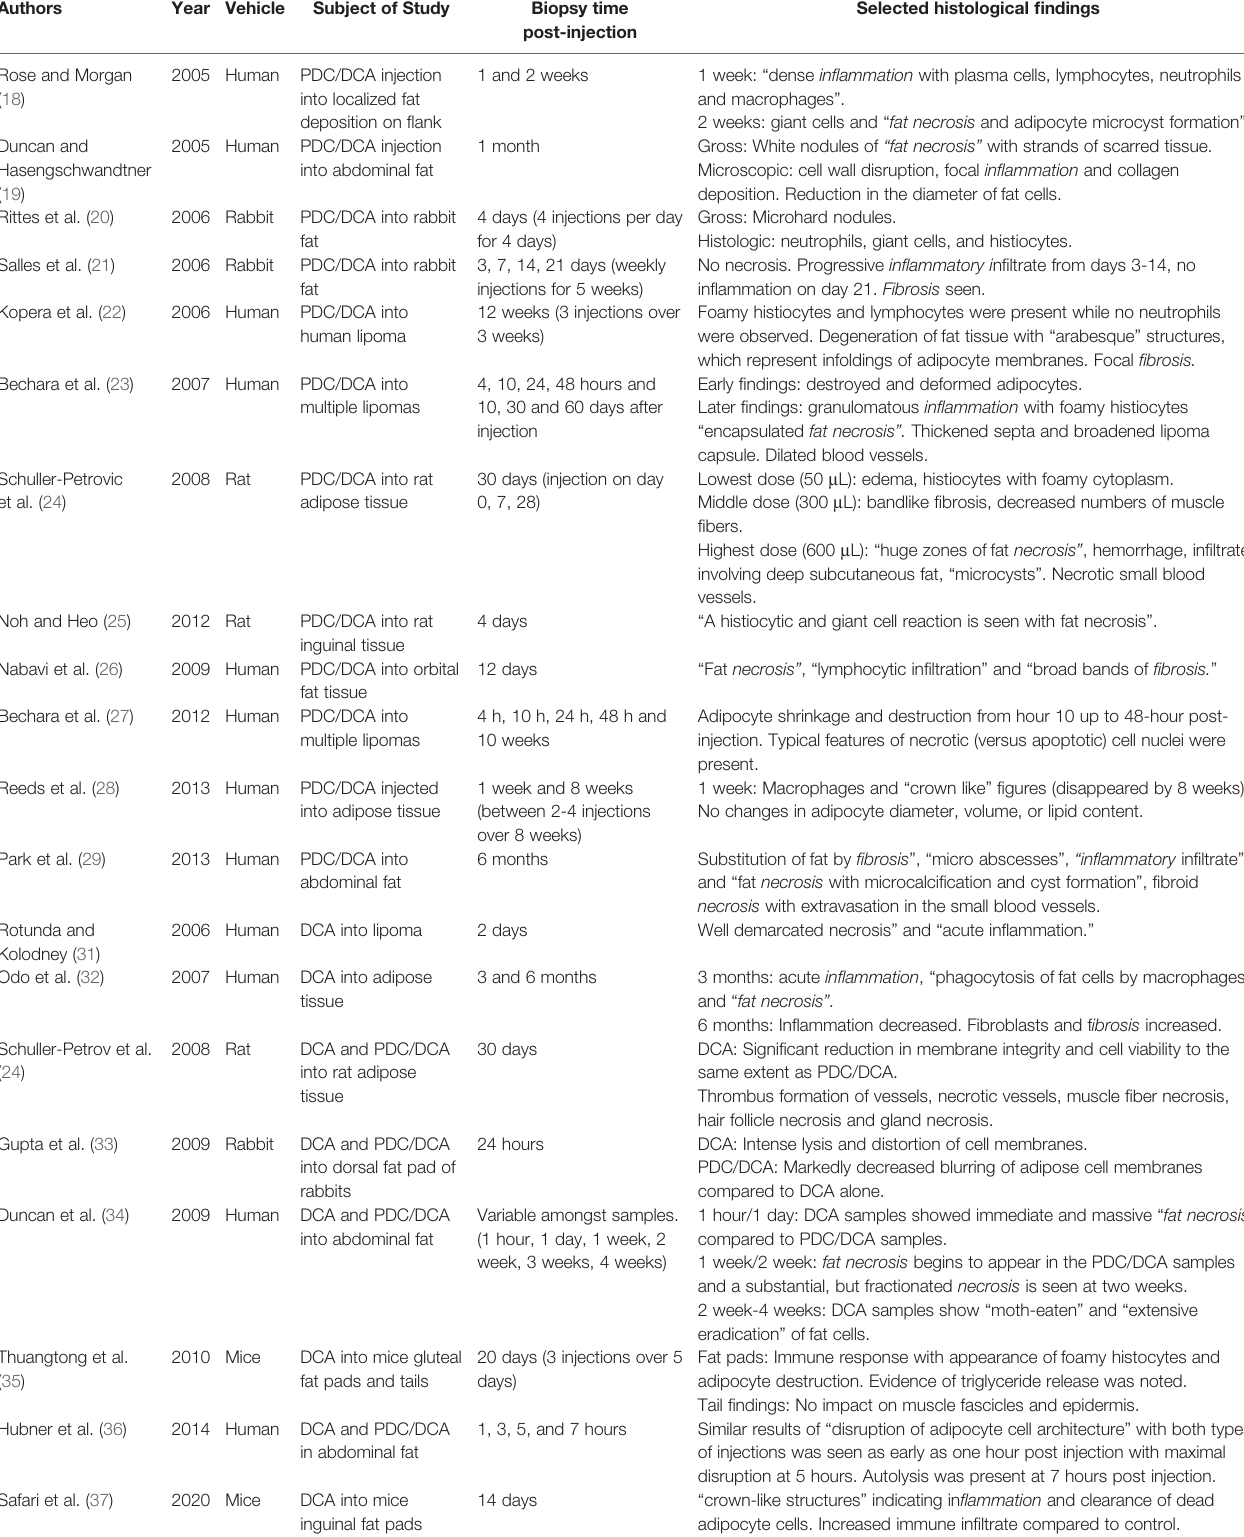
TABLE 1 | Histological Findings of PDC/DCA, DCA, and PDC injected adipose tissue. Authors